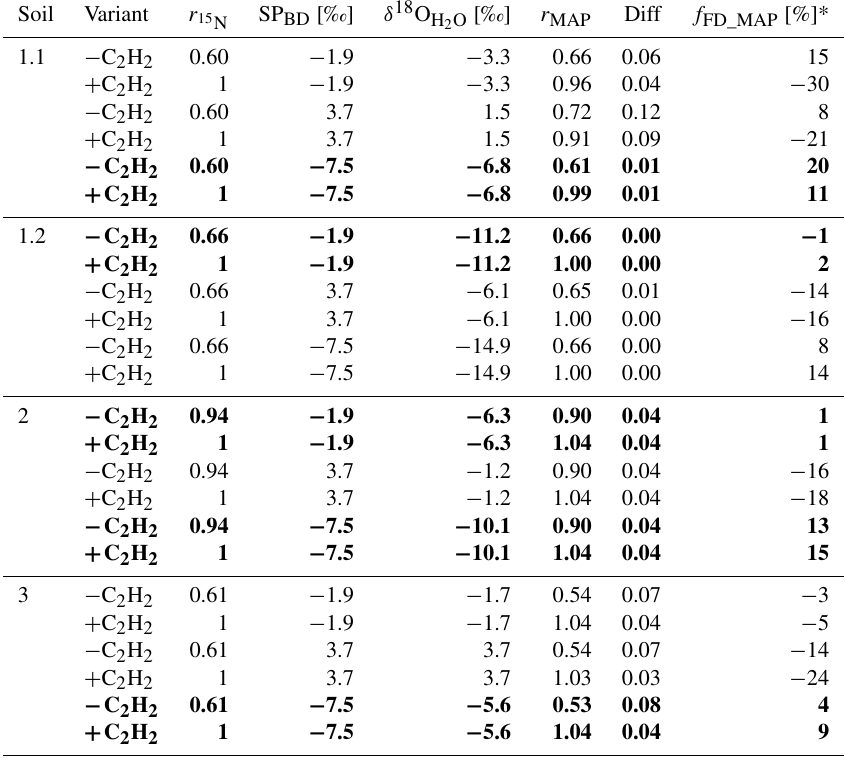
Table 4. Summary of the results provided by SP/ δ 18 O Map for fraction of fungal denitrification ( f FD_MAP ) and N 2 O product ratio ( r MAP ) in the acetylated ( + C 2 H 2 ) and non-acetylated ( − C 2 H 2 ) variants for three possible SP N ( − 1.9‰), maximal (3.7‰) and minimal ( − 7.5‰). The δ 18 O values of soil water ( δ 18 O H (Diff) between product ratio determined with 15 N treatment ( r 15 (see discussion for reasons for this